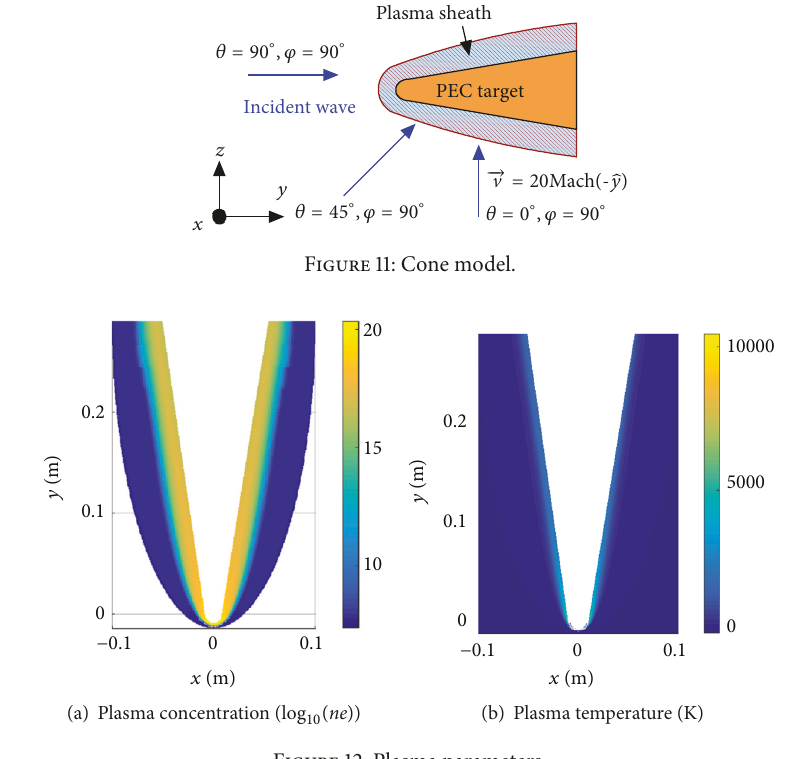
Figure 12: Plasma parameters.